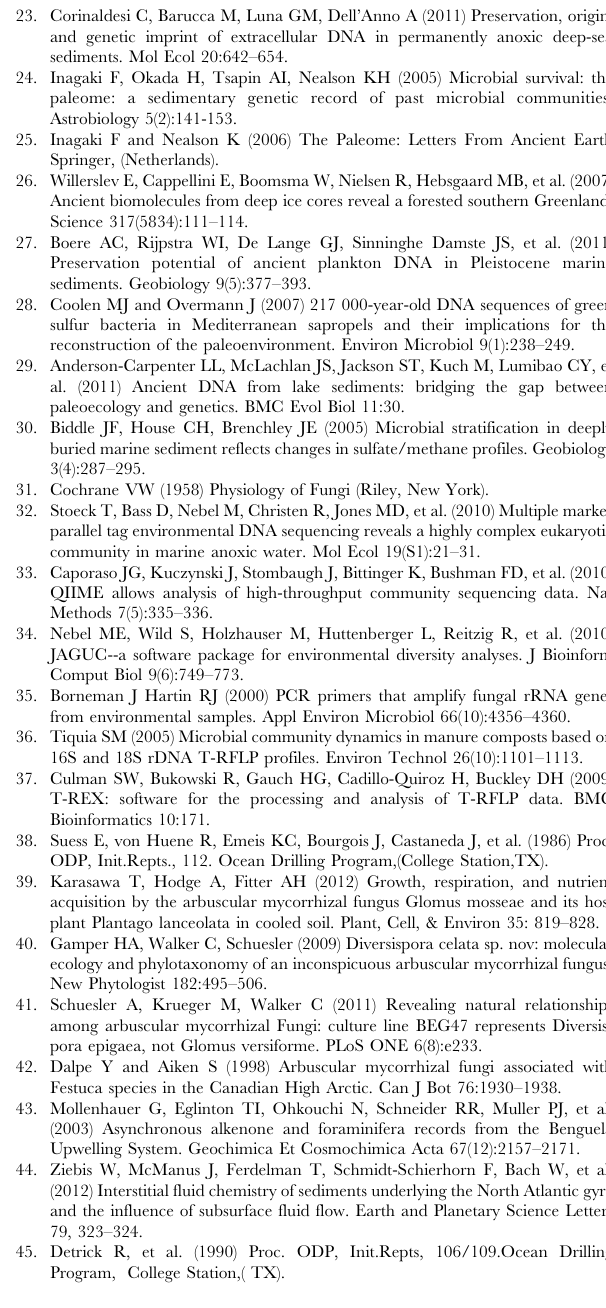
Table S3 Parametric and non-parametric estimates of fungal richness in subsurface sediments. See Table 1 for sample information. Table S4 Parametric and non-parametric estimates of eukaryotic richness in subsurface sediments and Sippe- wissett sediments. See Table 1 for sample